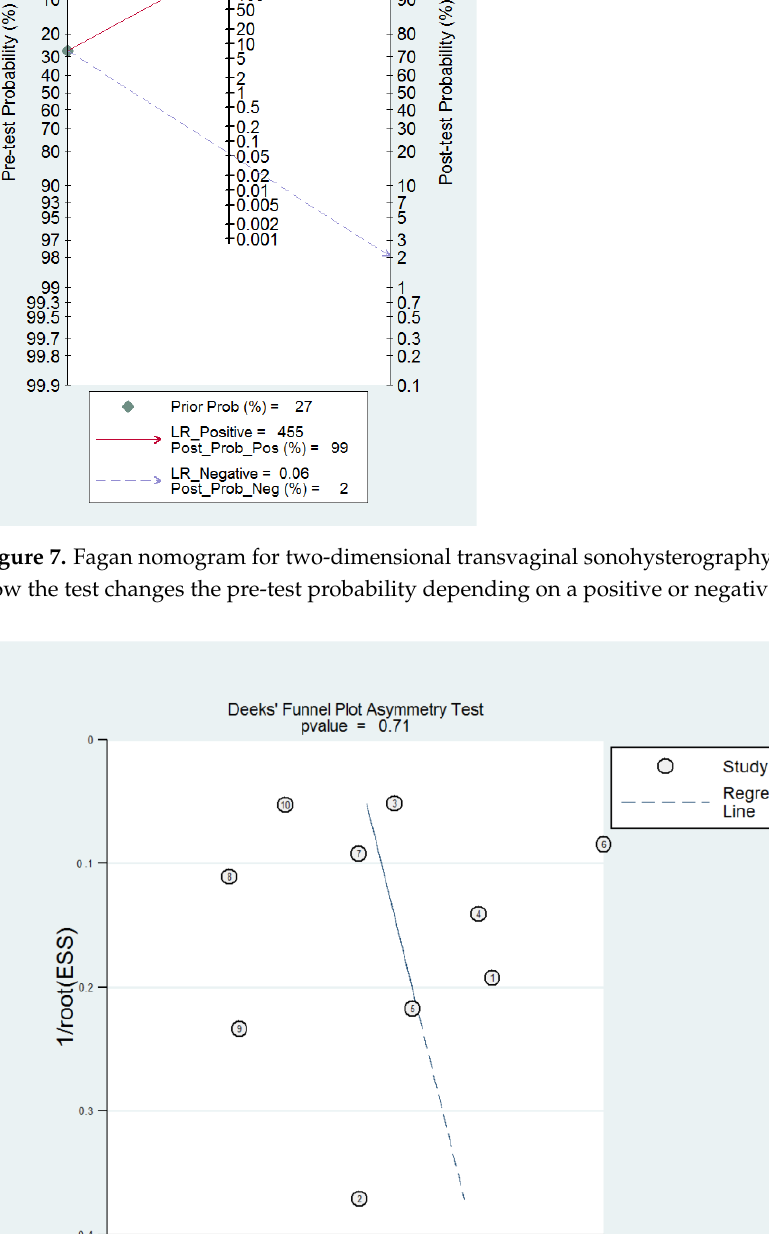
Figure 8. Publication bias regarding two-dimensional transvaginal ultrasonography .